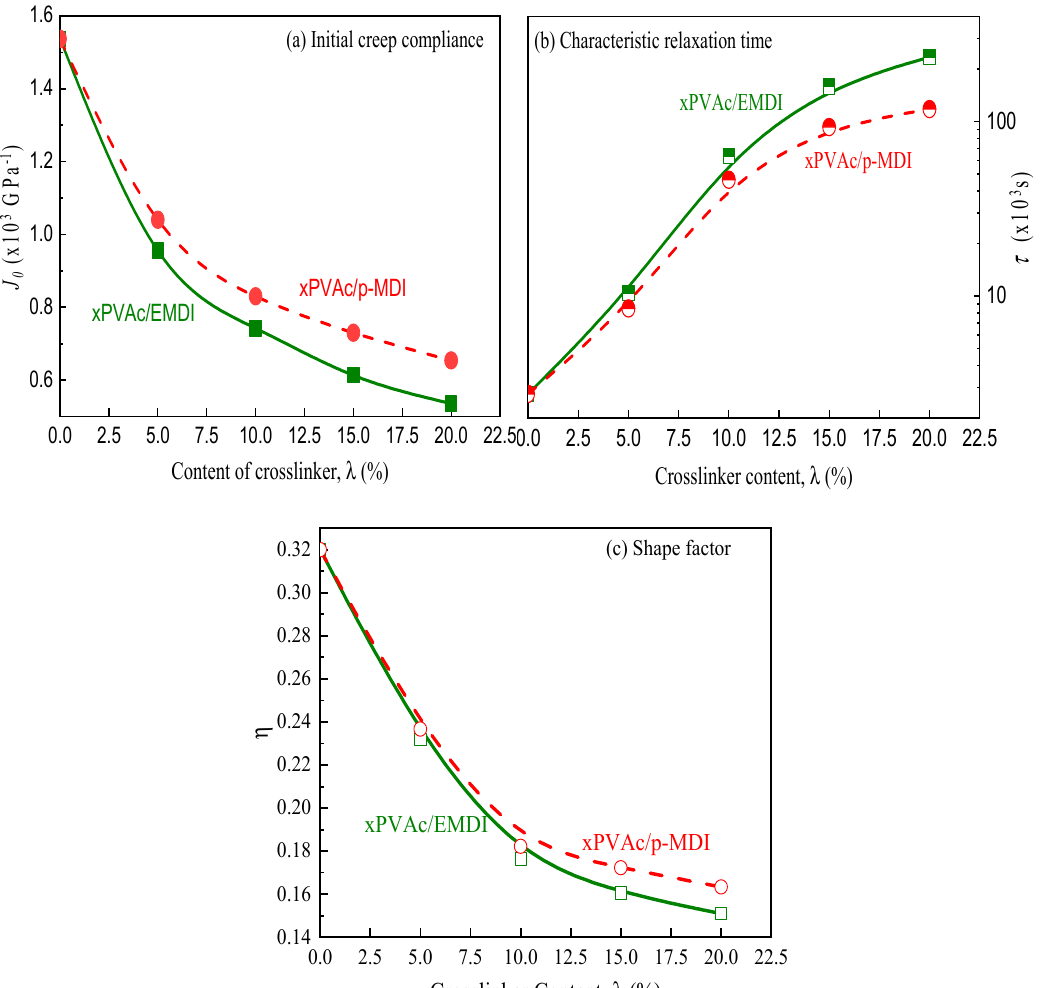
Figure 3. Effect of isocyanate crosslinkers on the KWW parameters. Figure 3. E ff ect of isocyanate crosslinkers on the KWW